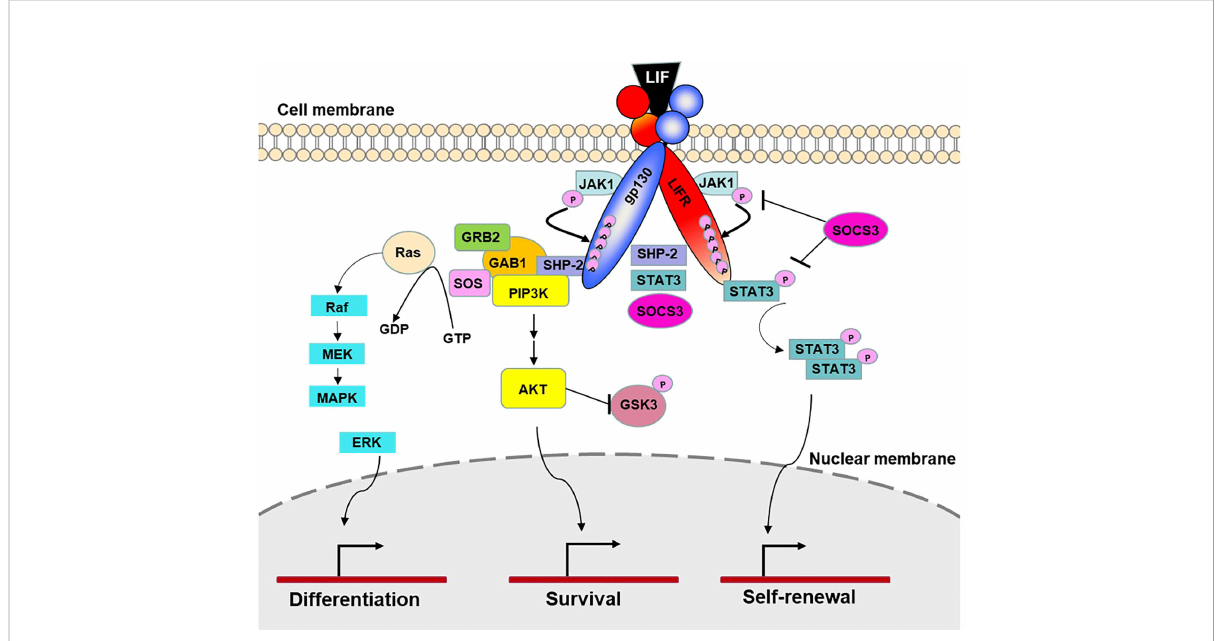
FIGURE 1 LIF signaling. LIF signaling occurs through a receptor complex of gp130 and LIFR. Under resting conditions, both receptor chains are constitutively associated with inactivated JAK1 molecules. Upon LIF stimulation, LIF binds to LIFR and gp130 and initiates signal transduction by transactivation of the gp130-bound and LIFR-bound JAK1 molecules. JAK1 then phosphorylates fi ve tyrosine molecules on each receptor chain, which create the docking sites for the transcription factors STAT3 and SHP-2, leading to activation of JAK/STAT3, MAPK and PI3K/AKT signaling pathways. The docking site also recruits transcription factor SOCS3, which is a predominant negative pathway that inhibits JAK-STAT3 activation. By controlling cellular differentiation, survival and self-renewal, these pathways collectively contribute to speci fi c physiological and immunological processes such as tissue homeostasis, hematopoiesis, pregnancy, bone remodeling, neuromuscular system, in fl ammatory conditions, and cancer (Nicola et al., 2015 and Rose-John et al.,